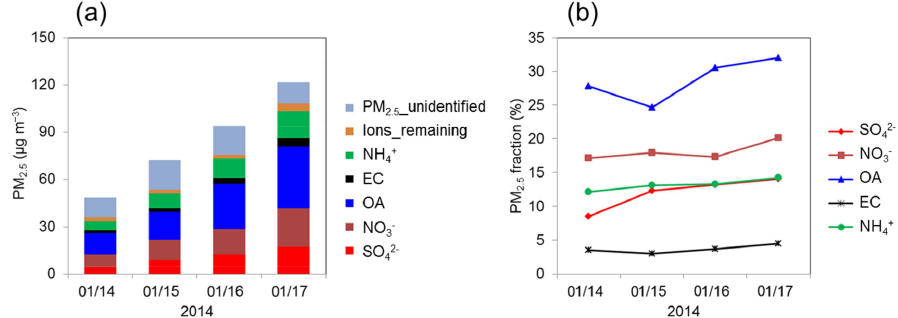
Figure 8. Temporal variations in (a) mass concentrations of PM 2 . 5 chemical components and (b) PM 2 . 5 mass fractions of major components during 14–17 January